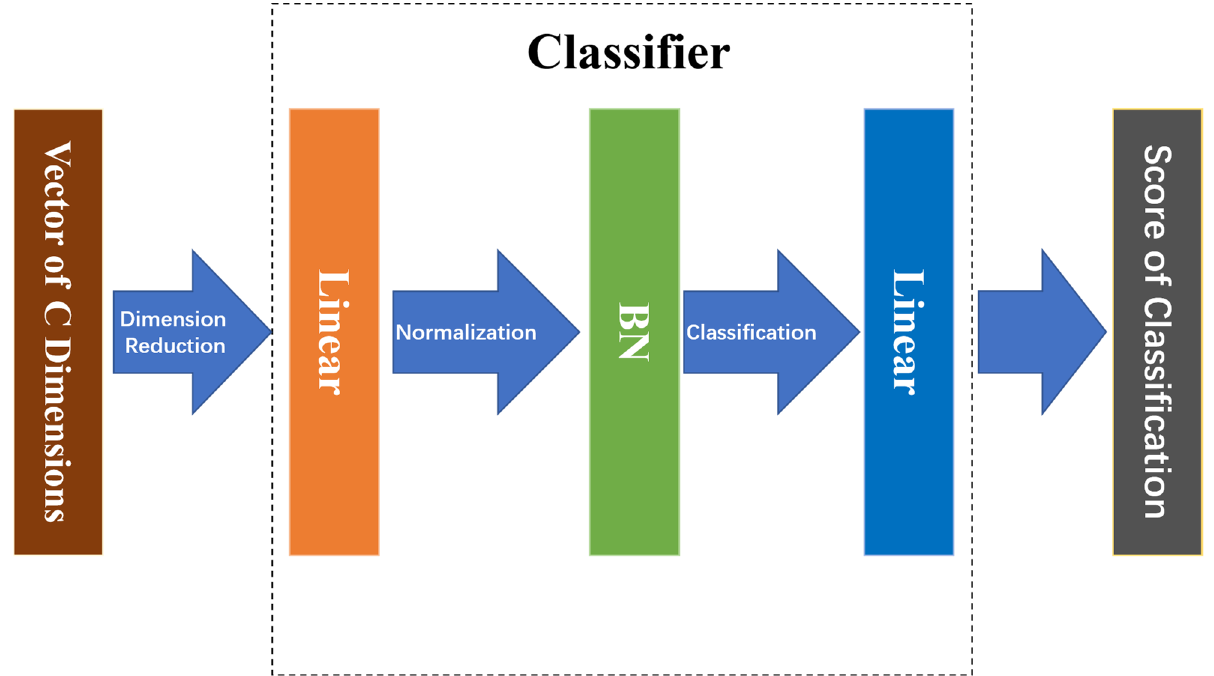
Figure 5. Architecture of